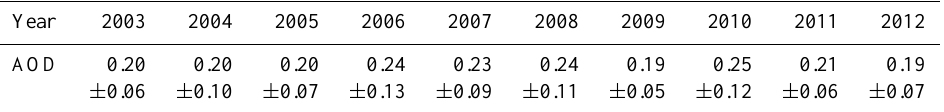
Table 1. MODIS-derived summertime mean AOD at 550nm ( ± standard deviation) within the aerosol layer over the ROI for 10 years